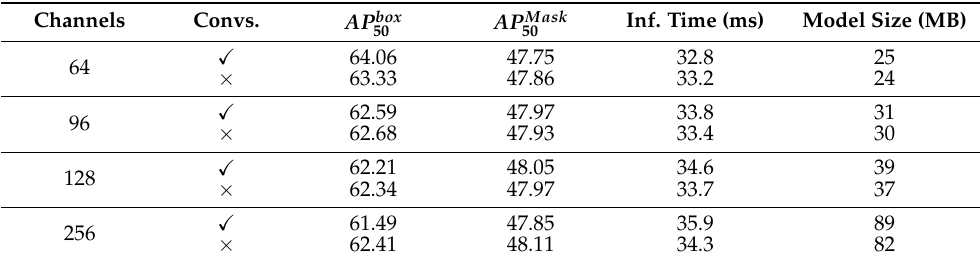
Table 2. Comparisons of different channels. Channels represents the number of input channels in FPN and convs. represents 3 × 3 convolutions in the FPN.